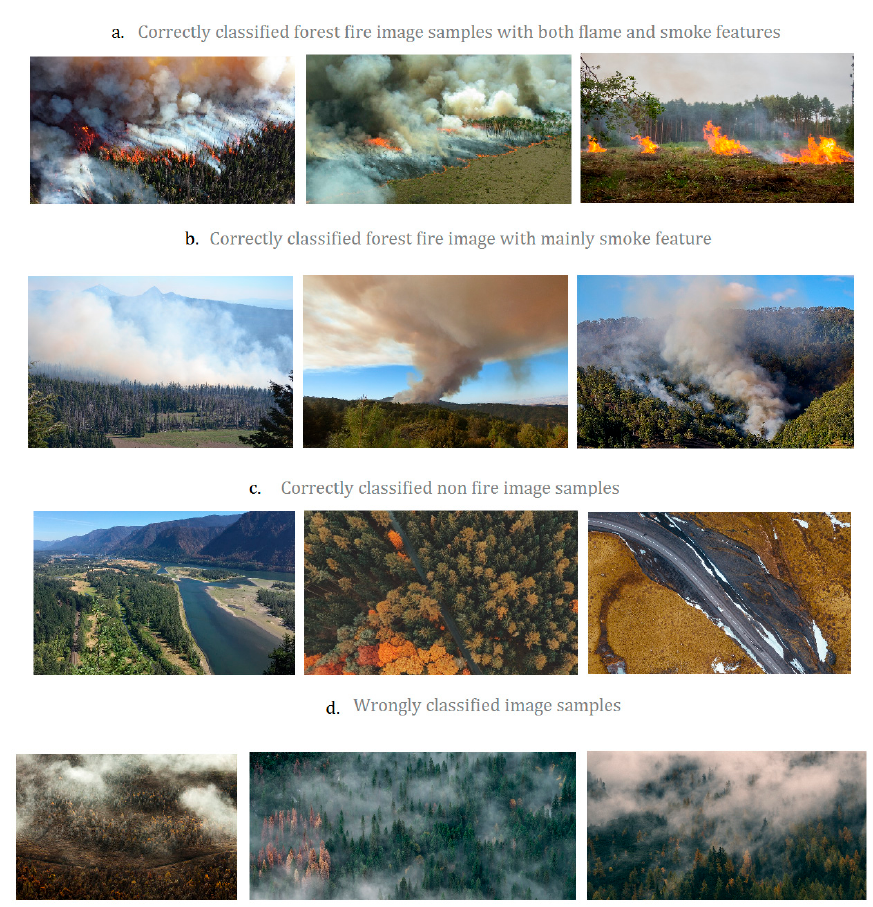
Figure 9. Visualization of feature maps after layer Conv2 and layer Conv3 in Fire_Net.